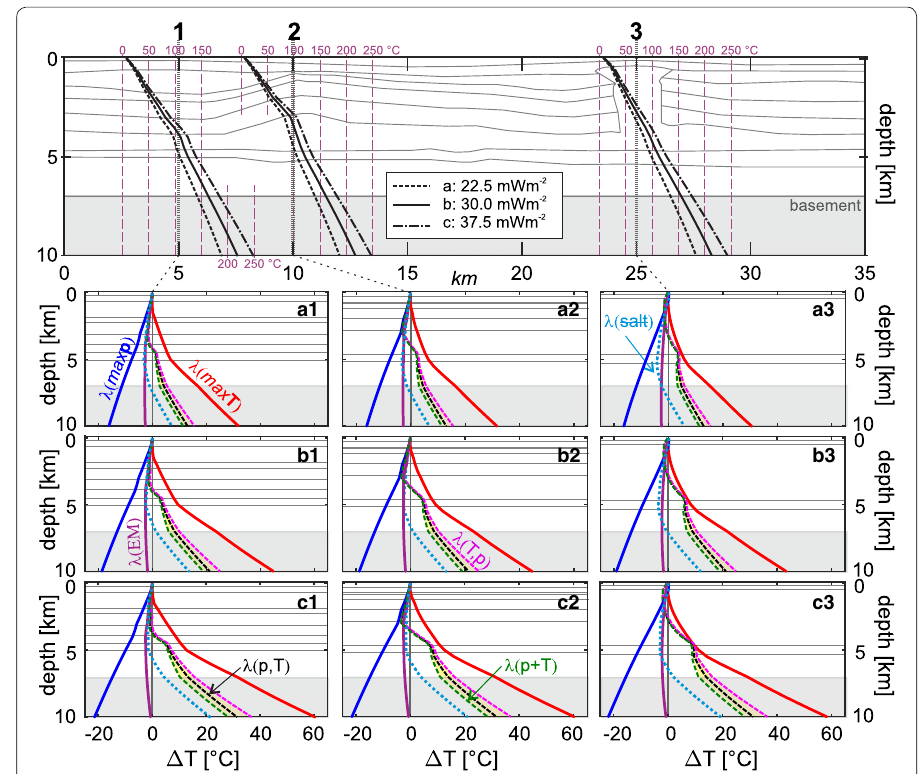
Fig. 6 Temperature profiles without correction of thermal conductivity (upper part) and temperature differences profiles (subfigures a1–c3) for scenario B (sedimentary section) at three different locations and for different basal heat flow in 30 km depth. Temperature differences are calculated against the uncorrected temperature profiles (relying on ambient thermal conductivities) based on different thermal conductivity ( λ ) correction methods: λ (max p )—maximum of pressure ( p ) correction on λ only, λ (max T )—maximum of temperature ( T ) correction on λ only (both as in Fig. 4); λ ( p , T )—combined correction of λ by correcting firstly for p and secondly for T , λ ( T , p )—combined correction of λ by correcting firstly for T and secondly for p ; λ ( p T )—combined correction of λ by adding the single p / T correction effects (correction formulas for + all ways as denoted in Table 2, rock‑specific sedimentary scenario); λ (EM)—using the correction formula of Emirov et al. (2017) for p and T below 400 MPa and 573 K, respectively, otherwise as denoted in Table 2; λ — correction like λ ( p , T ), but ignoring the salt‑specific correction formula for the rock salt layer (unit) and using sediments VS and rocks FF for T and p correction, respectively,